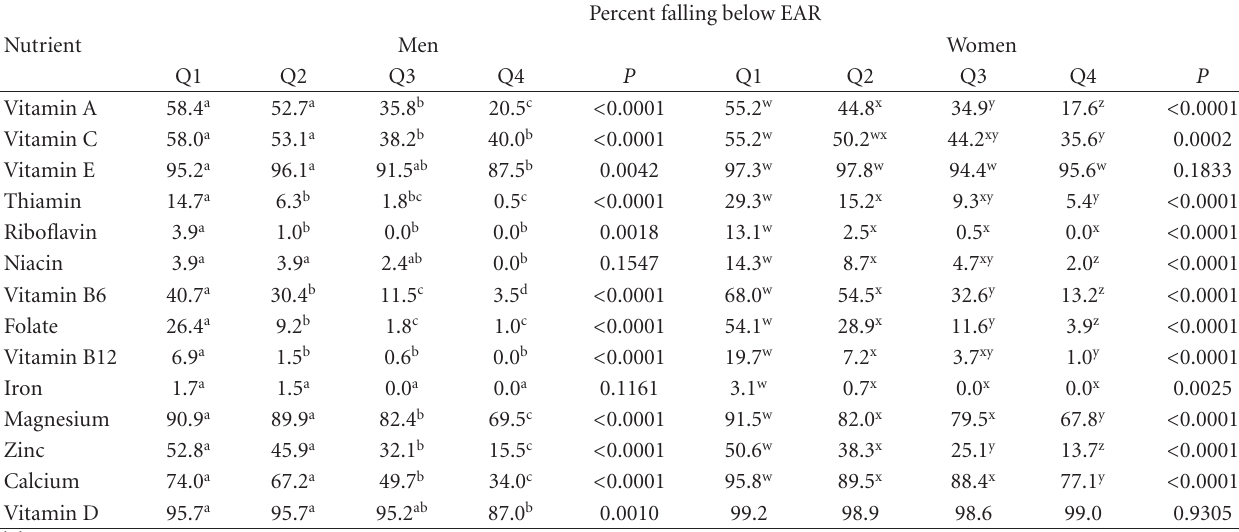
Table 4: Percentage of adults 55+ falling below the Estimated Average Requirement (EAR) by RTE cereal consumption pattern.